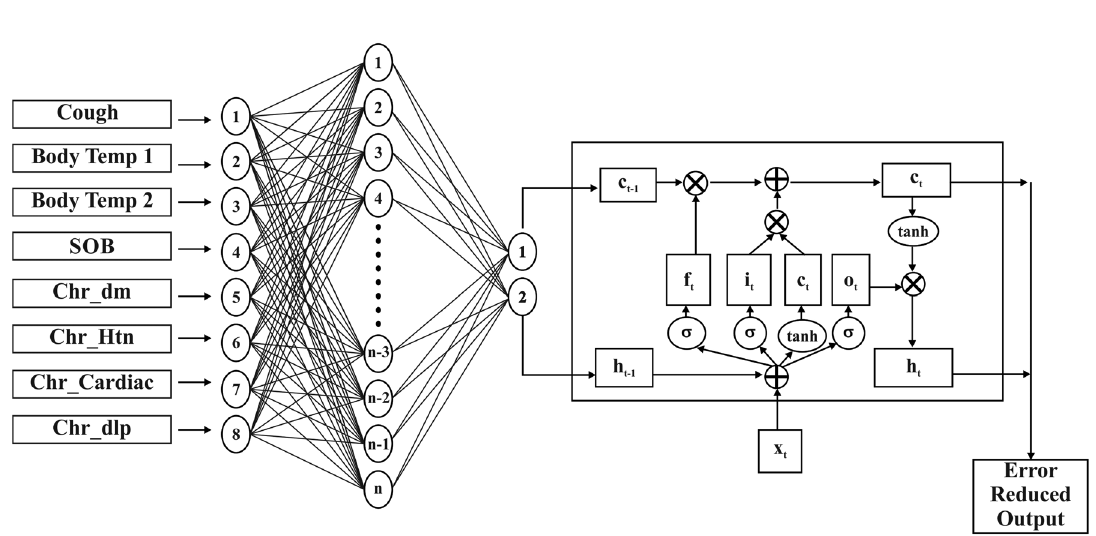
Figure 2: Architecture of recurrent neural network with